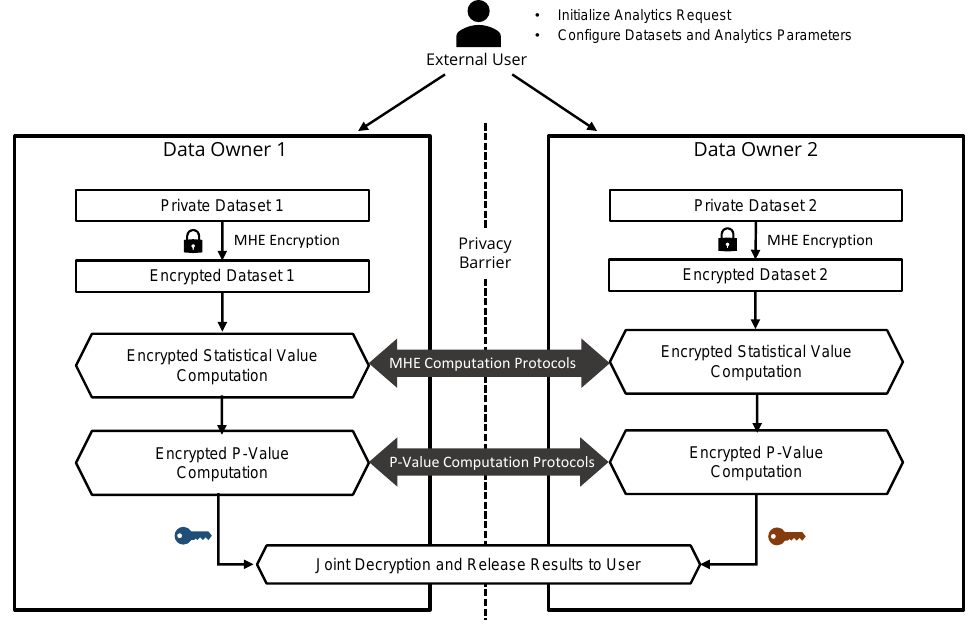
Figure 1. Federated analytics system